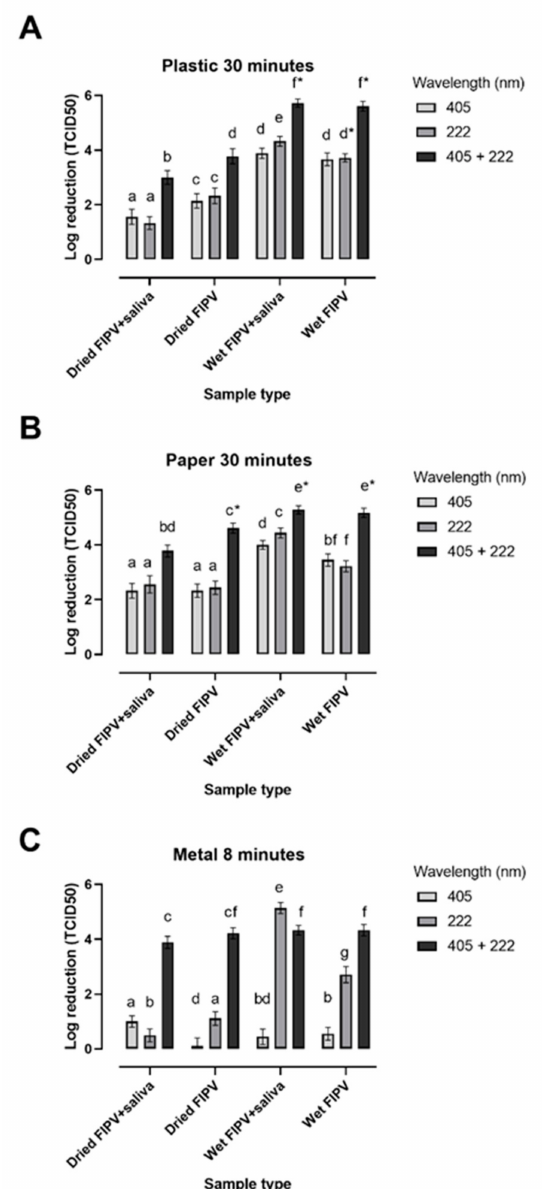
Figure 2. Log reduction of feline infectious peritonitis virus (FIPV) spotted on contaminated surfaces and exposed to blue LED (405 nm), far-UVC (222 nm) and dual (405 nm + 222 nm) lights. FIPV was either dried onto plastic ( A ), paper ( B ), or metal ( C ) discs in the presence or absence of saliva or left wet prior to being exposed to light for 30 min (plastic and paper) or 8 min (metal). All exposures were done at 25 cm distance. Data is displayed as mean log reduction in titre ± SD. Statistically significant differences are indicated by different letters (a to f), ( p < 0.05). * No CPE observed after large volume culture. TCID 50 = tissue culture infectious dose,